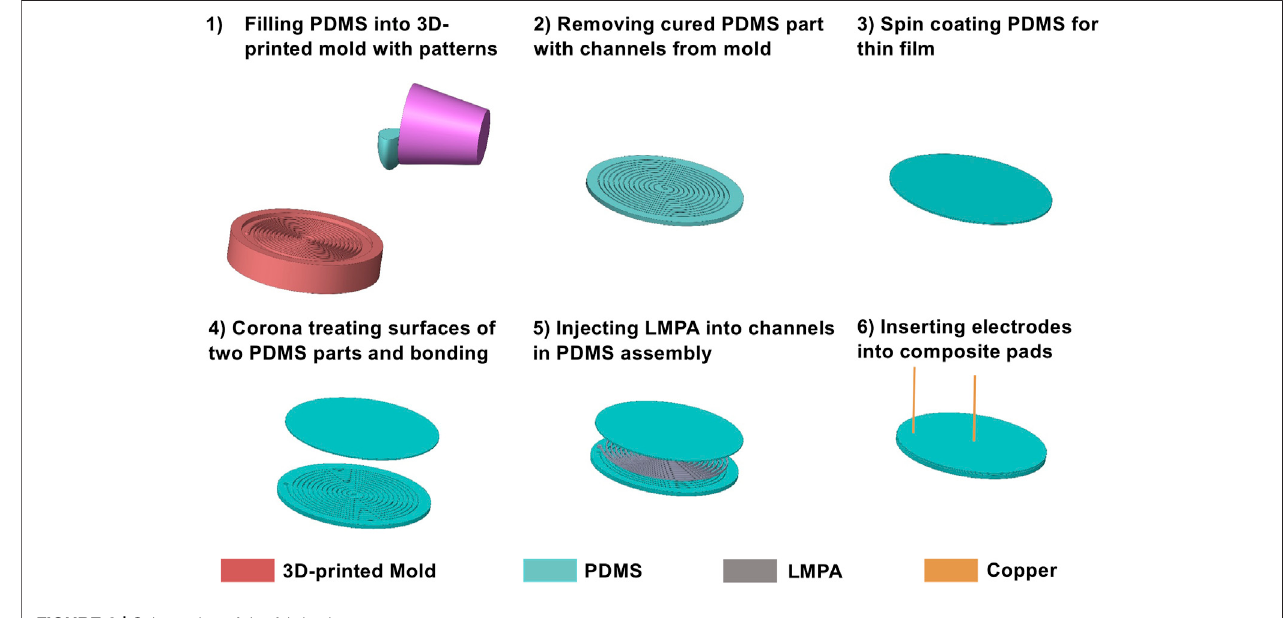
FIGURE 3 | Schematics of the fabrication process.